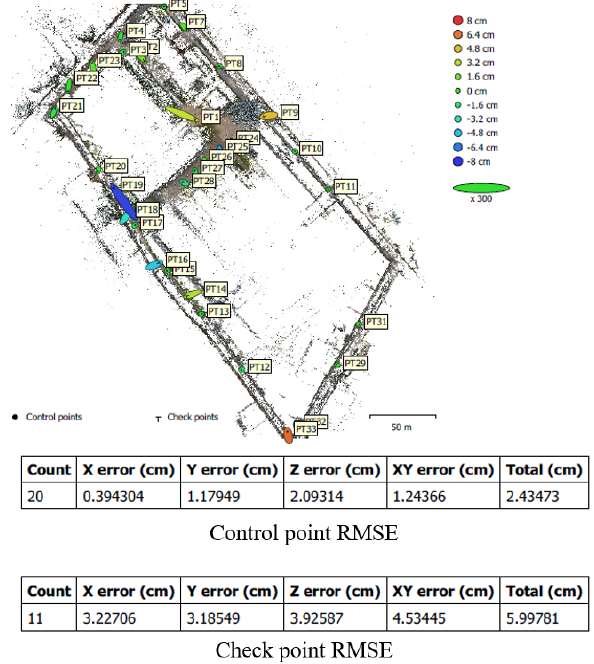
Figure 8: Statistics (in cm) after adding precise control points in the adjustment. After image orientation, additional points (31) were measured